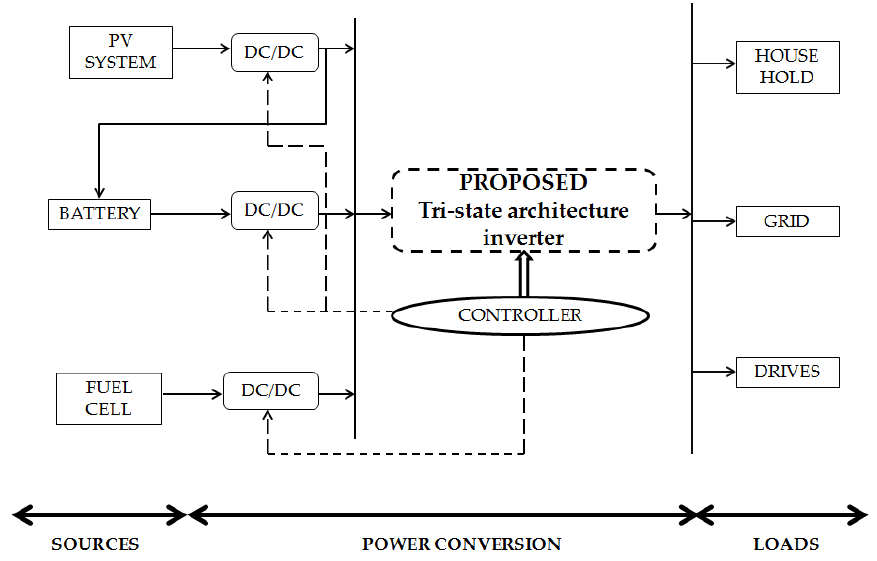
Figure 1. Proposed tri-state structure for PV/Fuel cell applications.